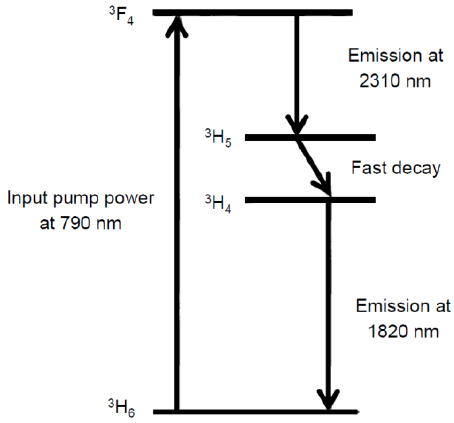
Figure 3. Tm 3+ doped monomode fluoride fiber laser proposed in [21]. Figure adapted from [21].